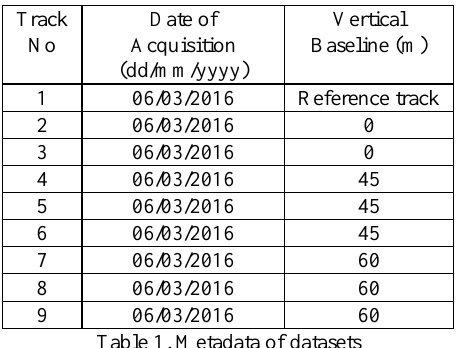
Table 1. Metadata of